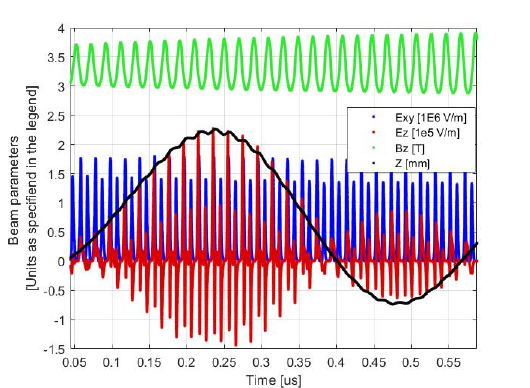
Figure 12. Details of beam transverse displacement evolution, magnetic field and electric field components during the first part of the acceleration inside the cyclotron.